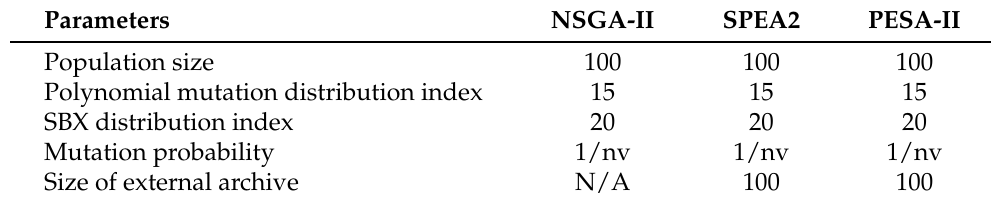
Table 2. Parameters for multi-objective algorithms (‘nv’ denoting the number of